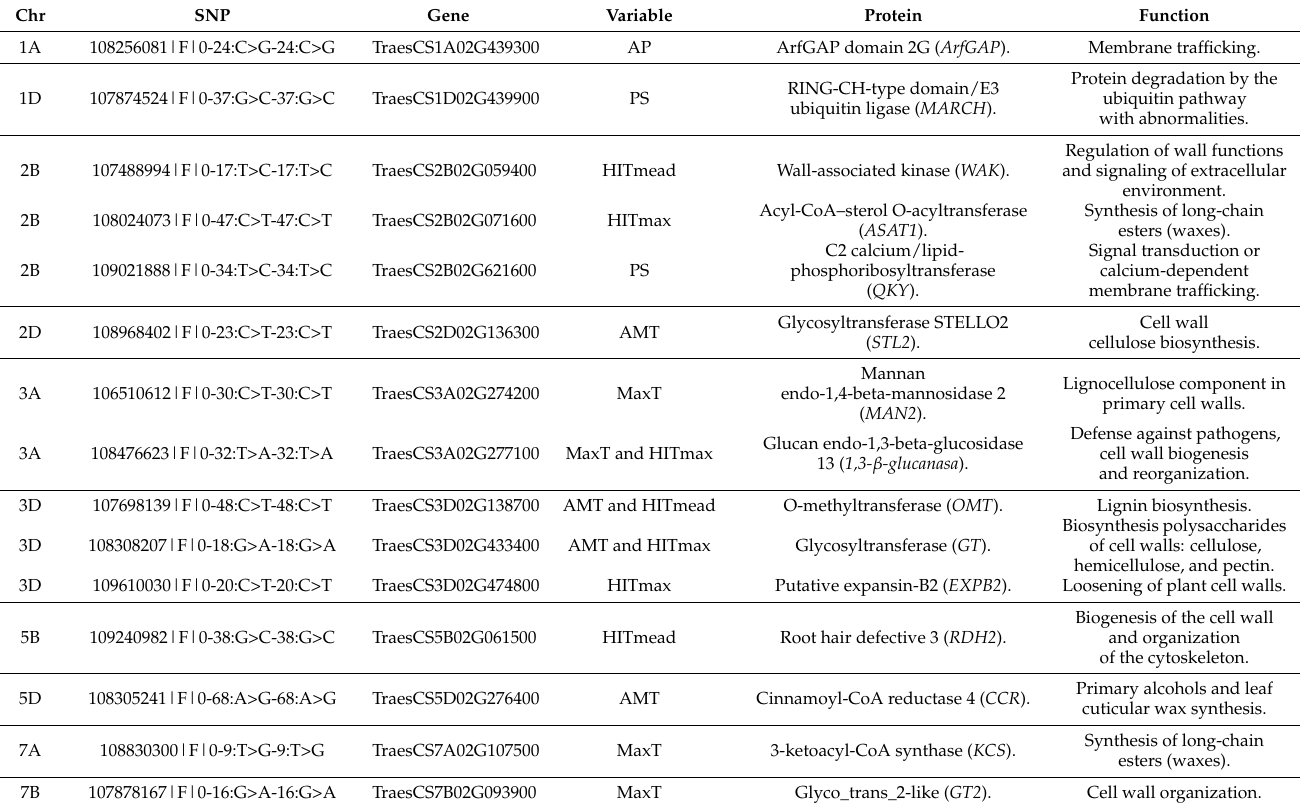
Table 4. Cell wall genes and proteins identified for Genome–environment Associations (GEA) with seven climatic